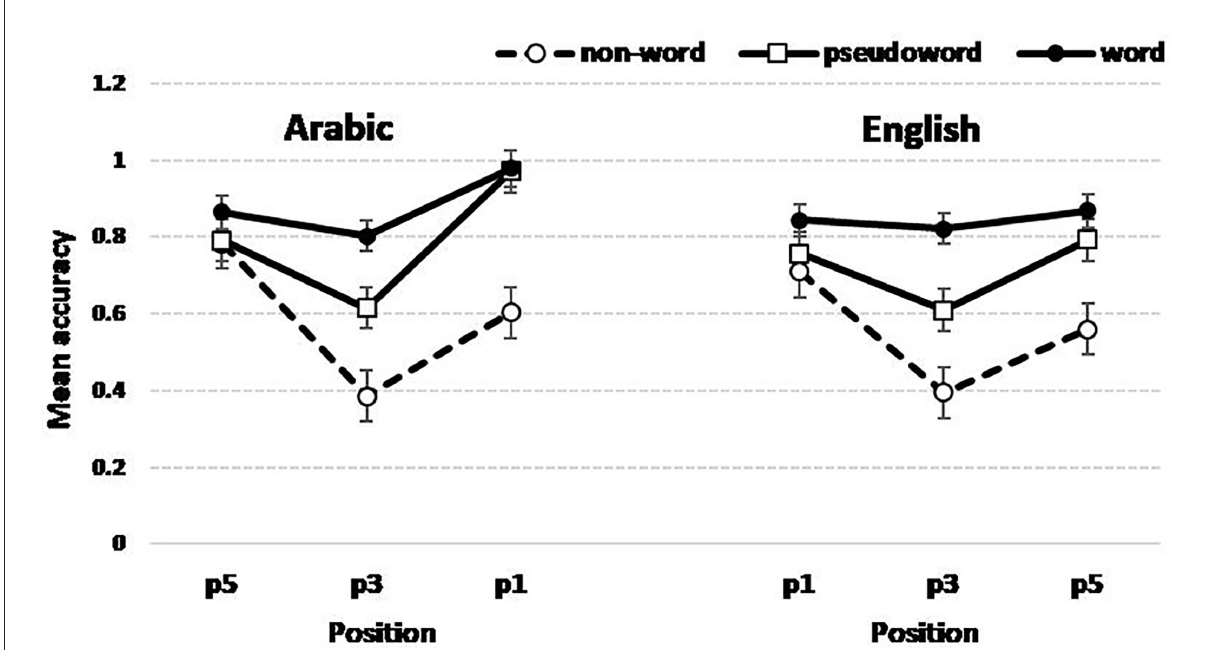
FIGURE5 Accuracy as a function of Language, String type (word, pseudo-word, and non-word), and letter Position. Note that the layout of the letter position in the left panel is from right to left in line with the reading direction in